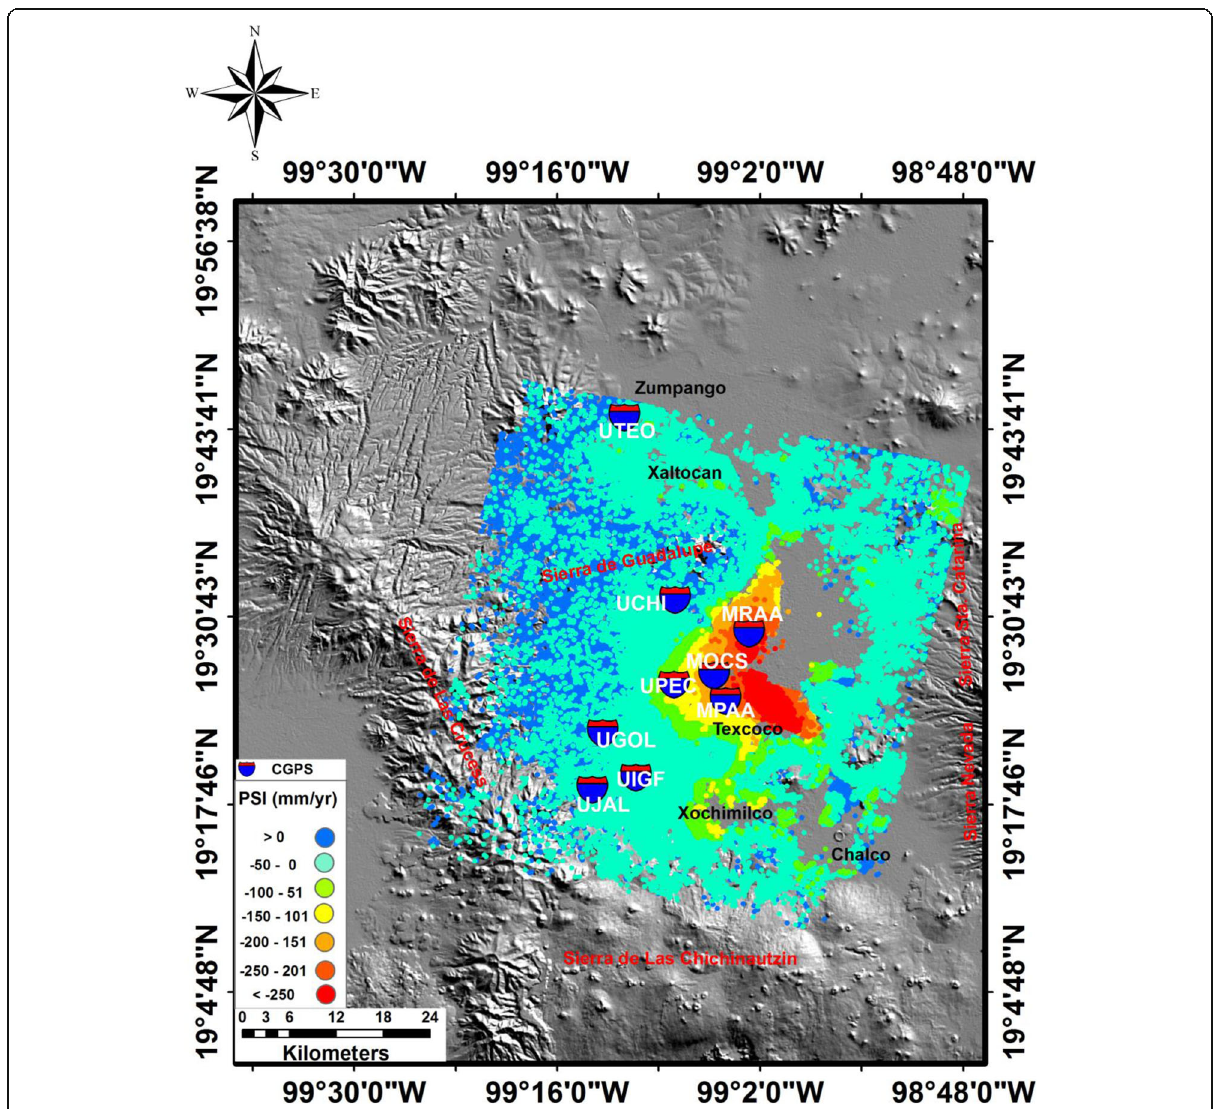
Fig. 8 PSI deformation rates of the Mexico City area for the temporal baseline of 2002 –